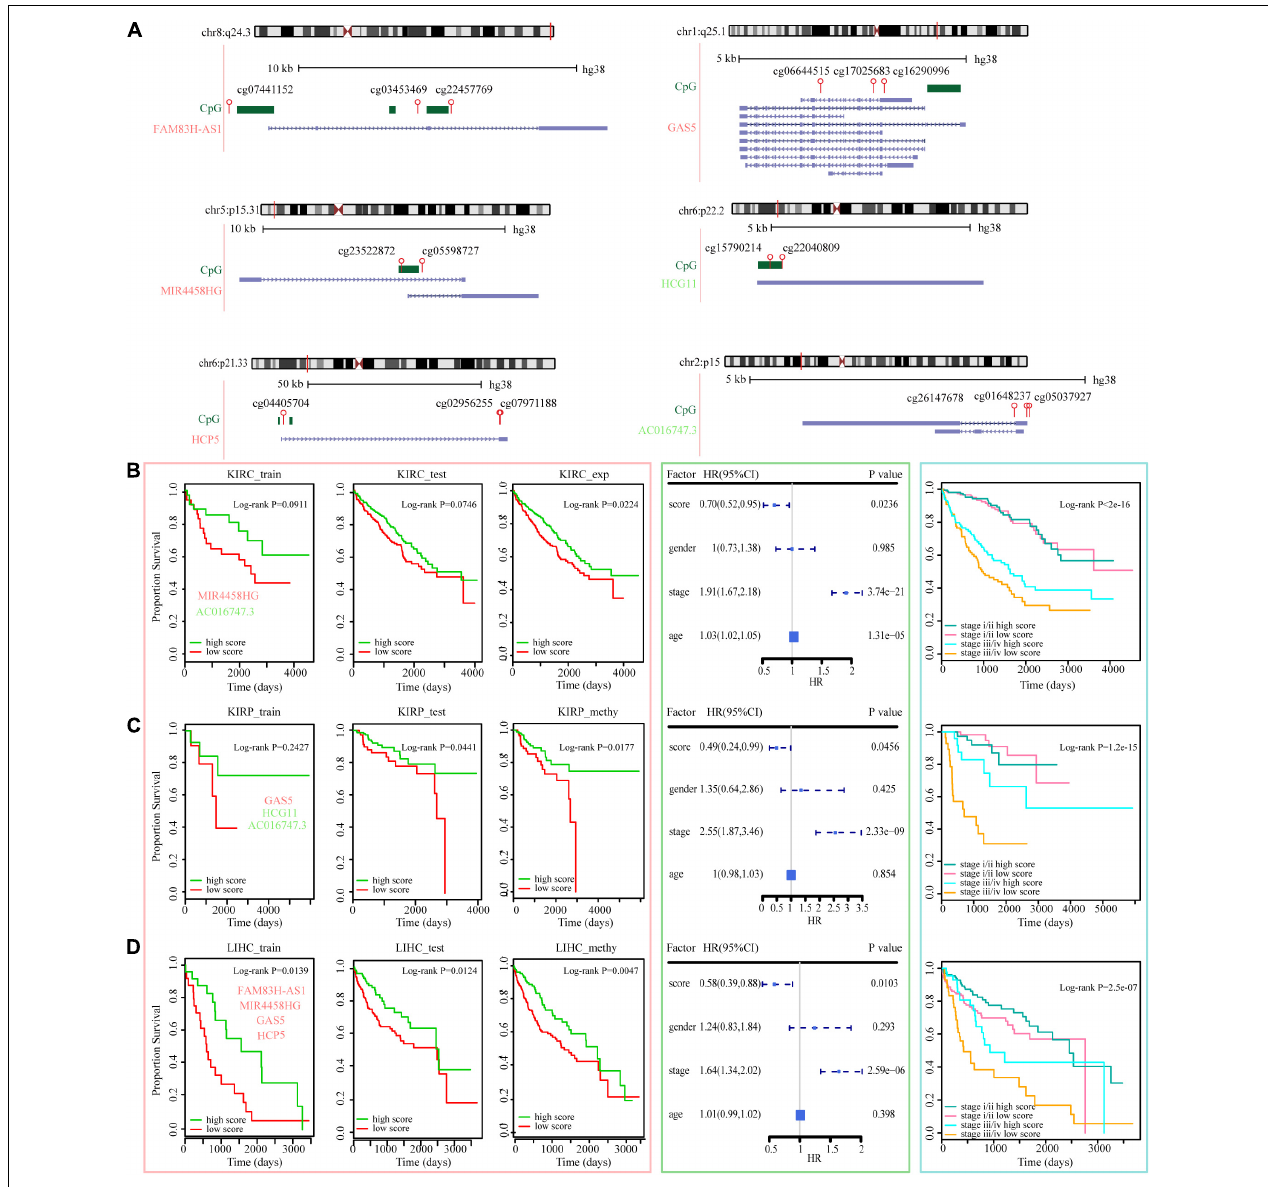
FIGURE 7 | ER lncRNAs as prognostic factors in various tumors. (A) The locations of ER lncRNAs occurred in three datasets (blue), CpG islands (green), and HM450 probes (red) in GRCh38 reference human genome. The symbol colored red represents EA lncRNAs, and the symbol colored green represents ES lncRNAs. (B – D) Kaplan–Meier estimates of OS of patients with KIRC expression, KIRP methylation, and LIHC methylation levels according to the ER lncRNA signature. Kaplan–Meier estimates of the OS of patients in train, test, and all sets according to the ER lncRNAs are shown in the left panel. The hazard ratios of clinical factors using a multivariate Cox regression model are shown in the middle panel. Kaplan–Meier estimates of the OS between low-stage and high-stage patients according to the ER lncRNAs are shown in the right